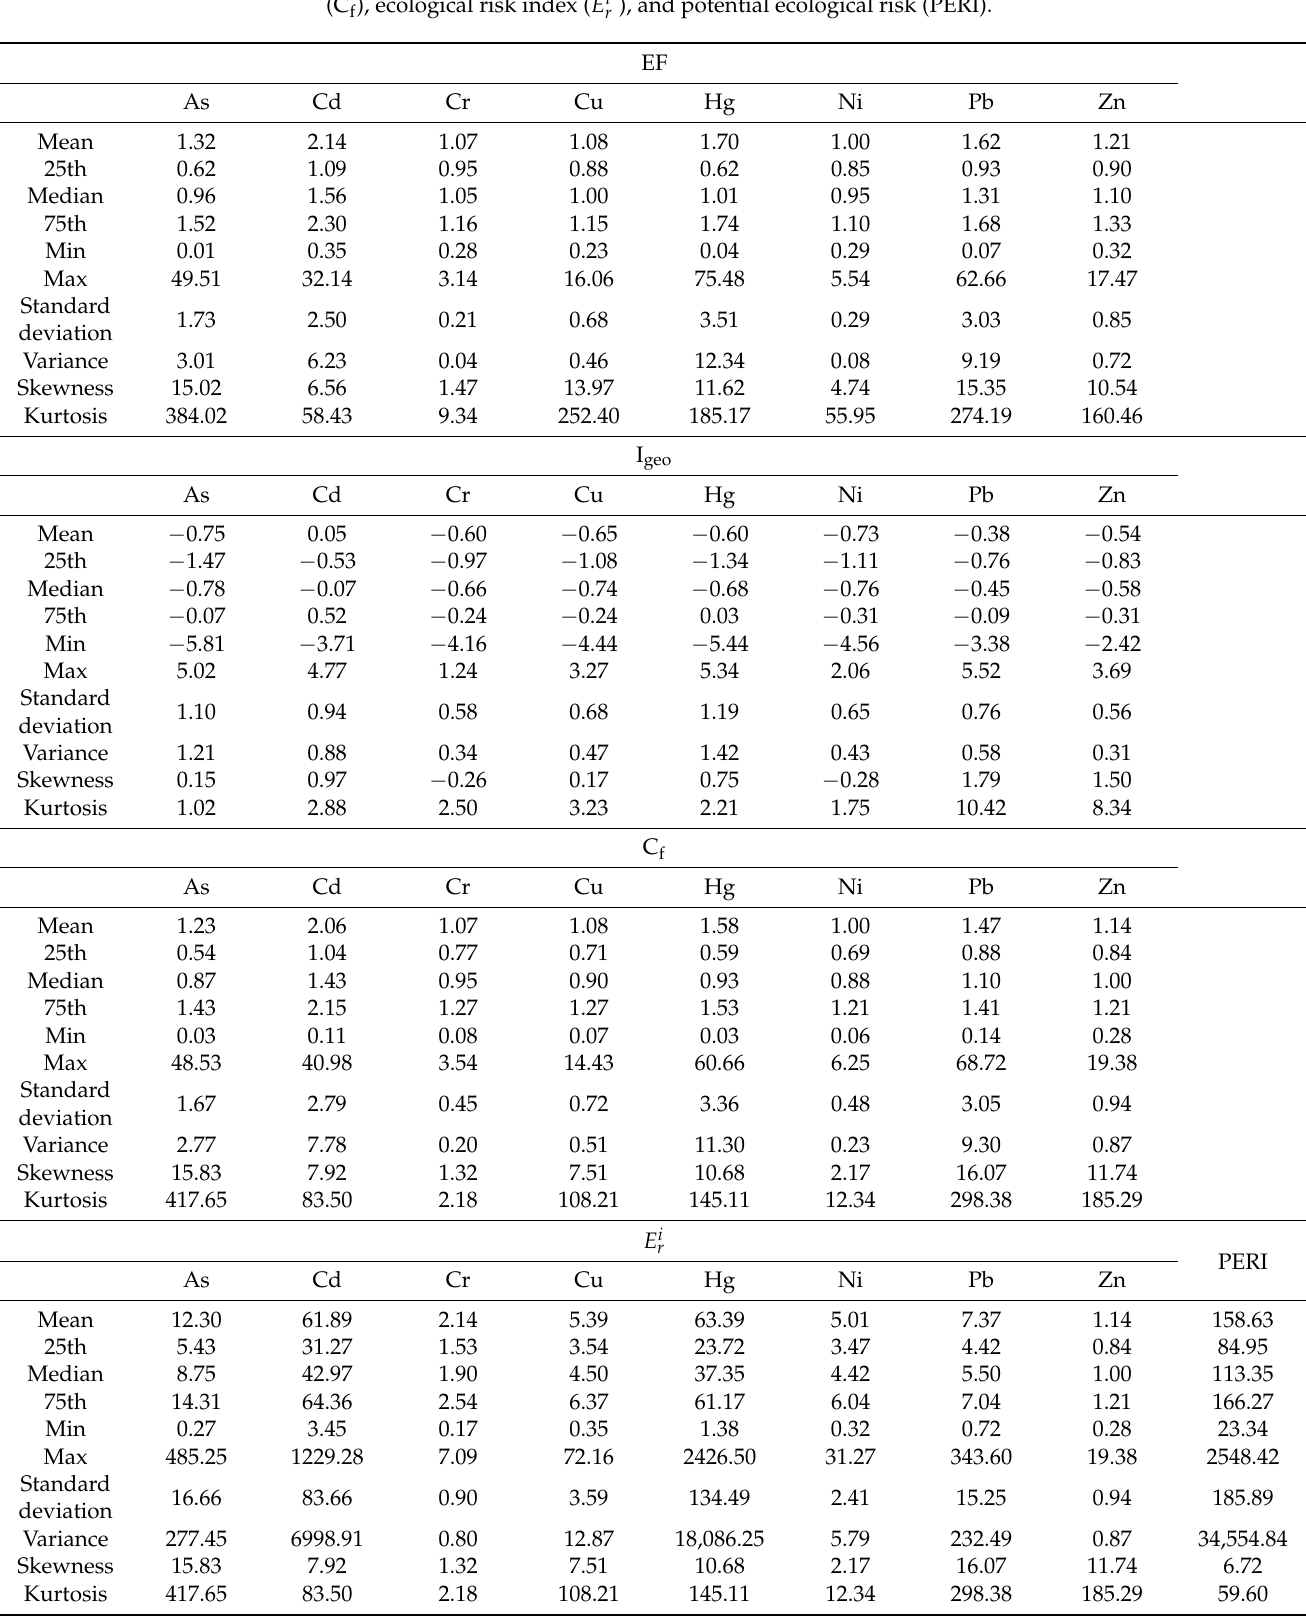
Table 5. Descriptive statistics of the environmental and ecological risk assessment of PTEs in the examined soils using the enrichment factor (EF), geo-accumulation index (I geo ), contamination